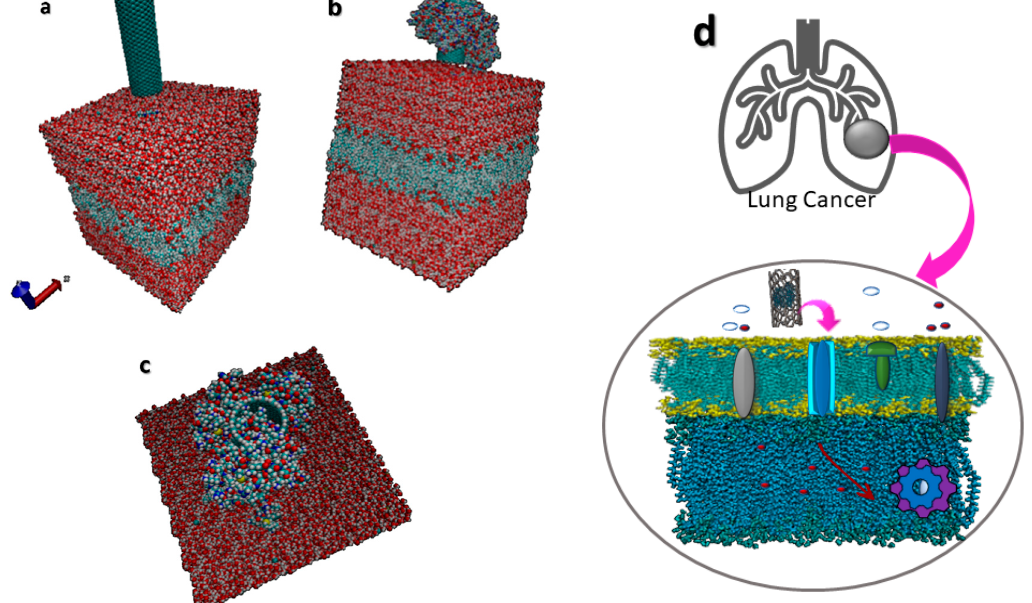
Figure 5. Carbon nanotube above membrane: ( a ) simple CNT above the membrane, ( b , c ) functionalized CNT above the cell membrane in two different orientations, ( d ) lung cell membrane and a functionalized CNT above the membrane.